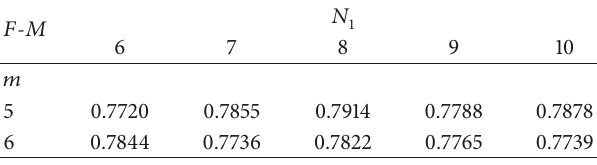
Table 1: Further experiments to choose 𝑁 1 and 𝑚